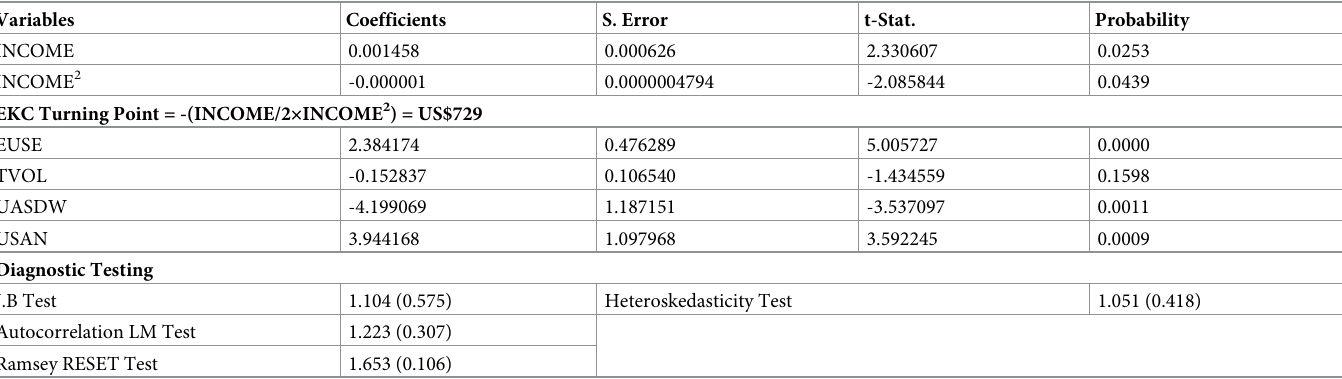
Table 7. ARDL long-run